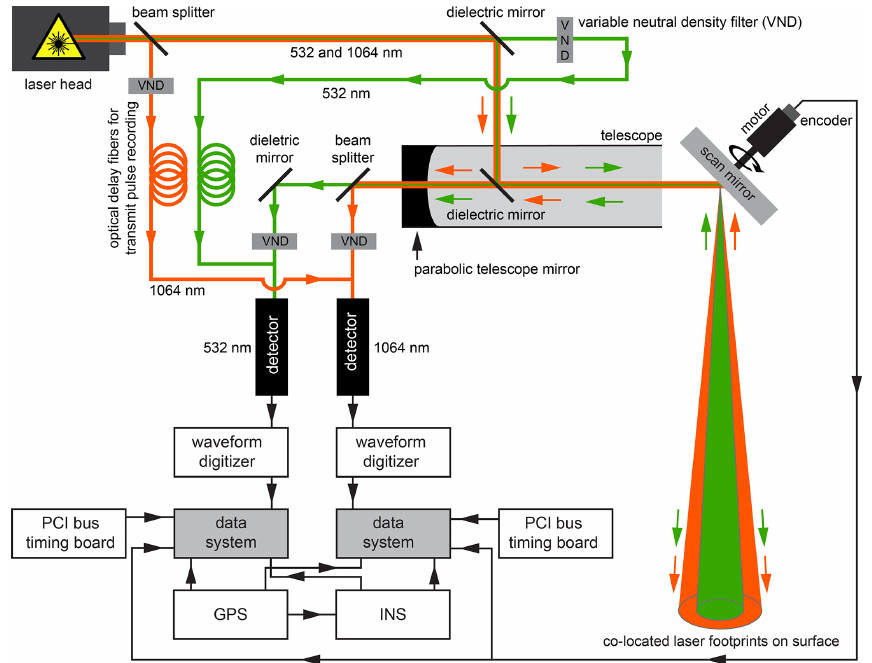
Figure A3. Schematic diagram of ATM’s dual color T7 transceiver with co-located green (532nm) and IR (1064nm) footprints.